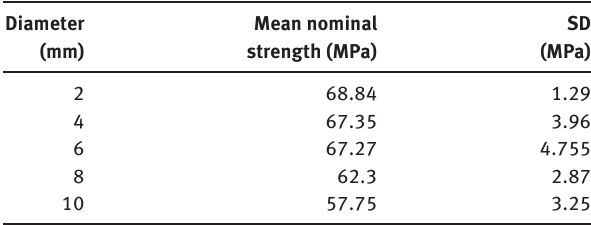
laminates open hole. s